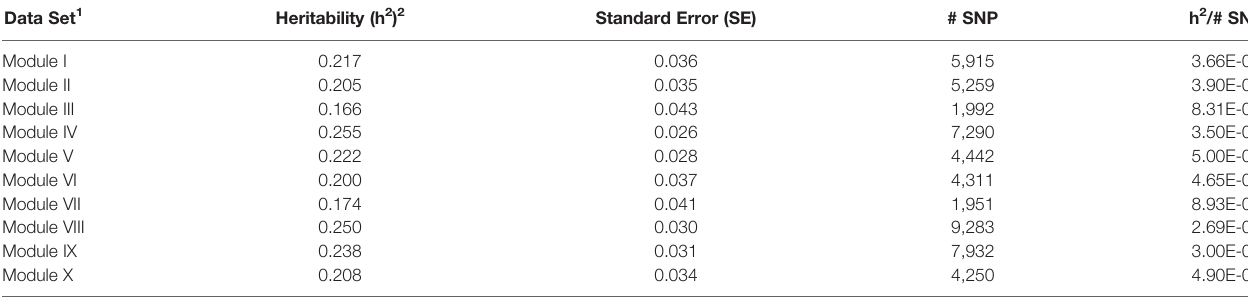
TABLE 9 | Heritability estimates for feed ef fi ciency from weighted genome-wide association studies (GWAS) utilizing SNP with weight > 2. Data Set